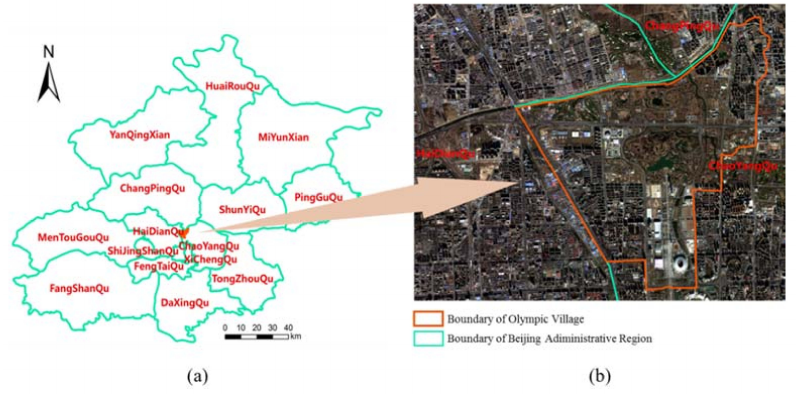
Figure 1. Location of the Olympic Village area. ( a ) Location of the Olympic Village within the administrative divisions of Beijing; ( b ) remote sensing imagery showing the boundaries of the Olympic Village within central